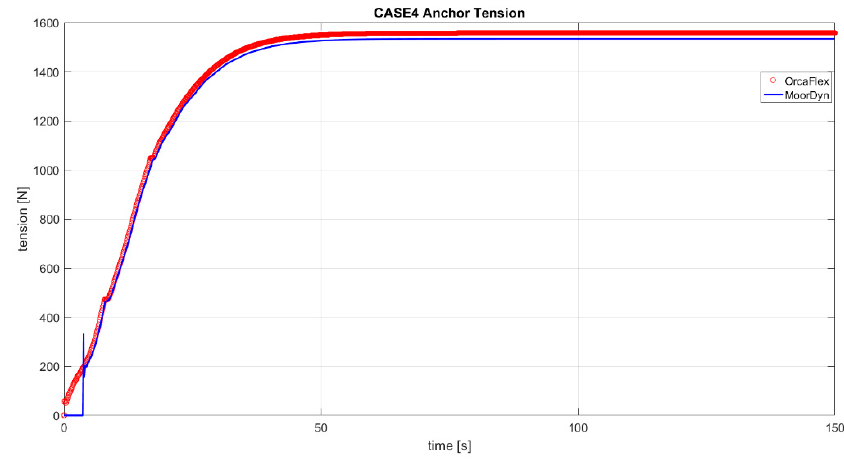
Figure 15. Simulation case 4: Time series of buoy’s position.